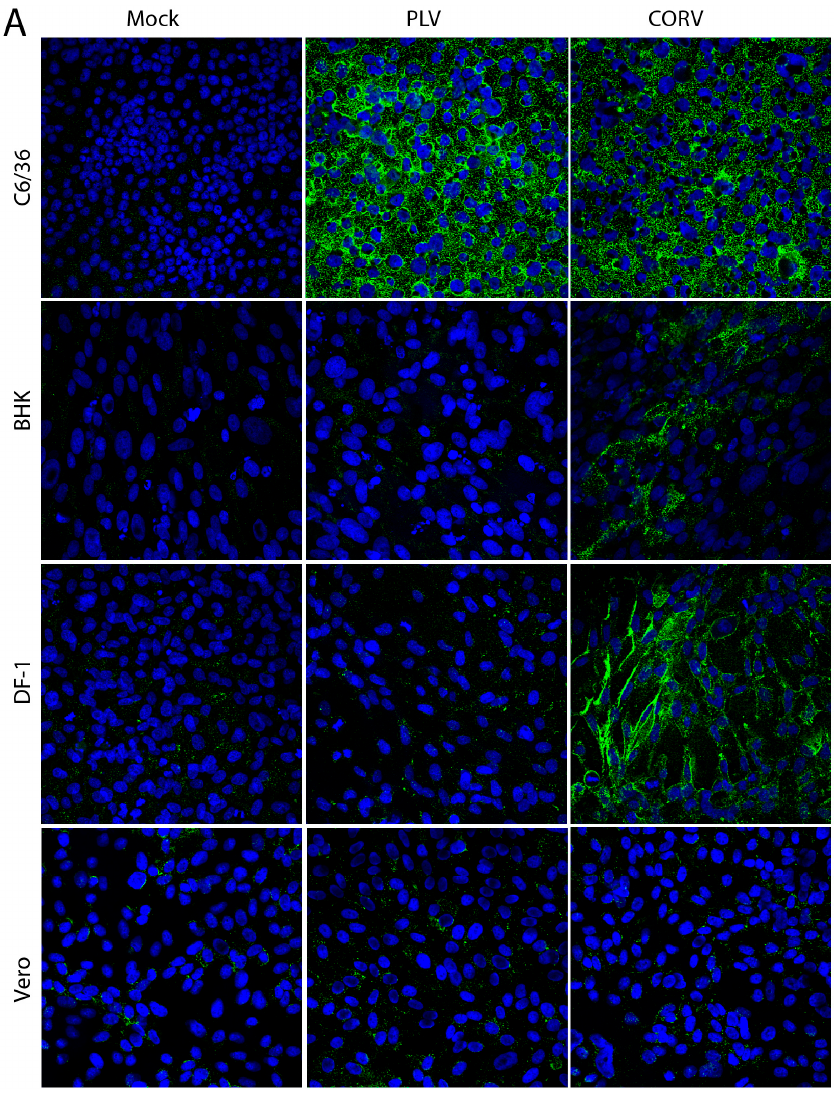
Figure 3. Cont Figure 3. Cont.